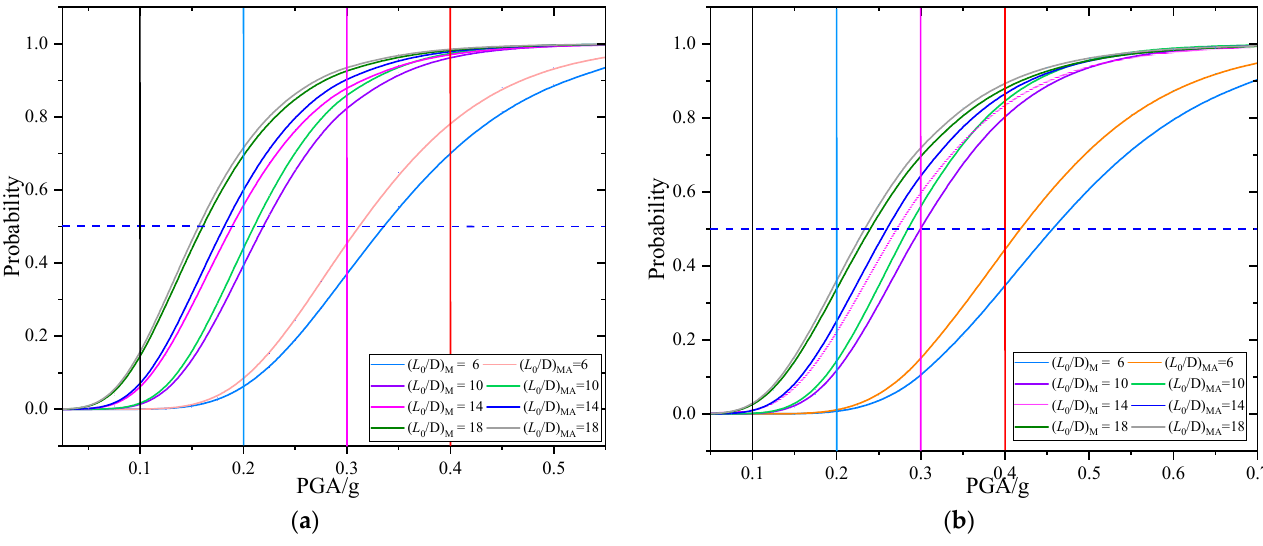
Figure 12. Fragility curves of the column: ( a ) Medium damage; ( b ) Serious damage.